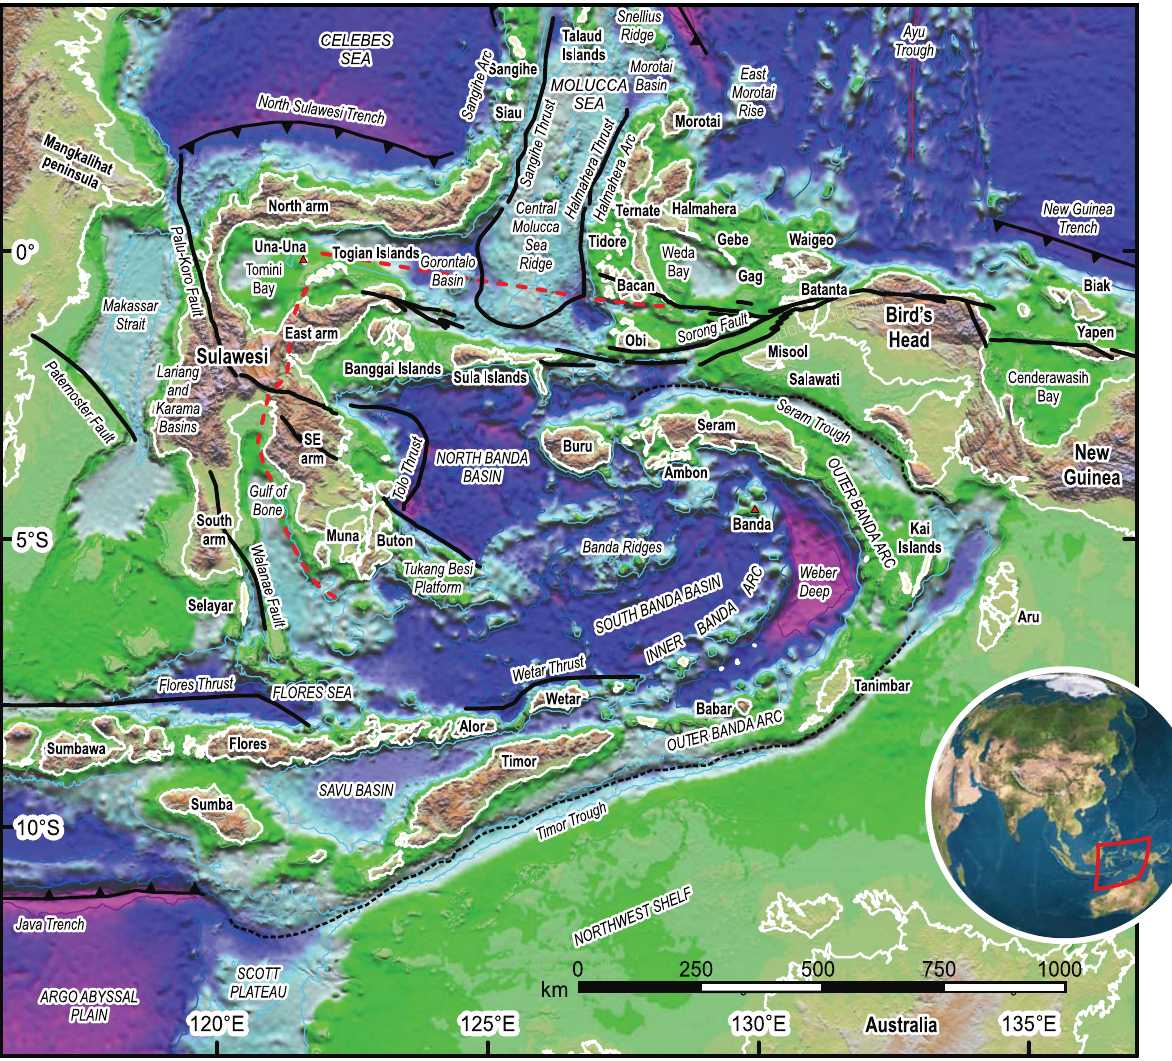
Fig. 1. SRTM image of eastern Indonesia showing the Banda Arc and the location of the islands of Seram and Ambon. Faults are marked by solid black lines; subduction zones are indicated by toothed black lines; the surface expression of Banda Arc subduction – the Seram Trough and Timor Trough – are indicated by dashed black lines. The dashed red line shows the approximate limit of the Sula Spur (from Hall, 2012). Inset (bottom-right) indicates map location in SE